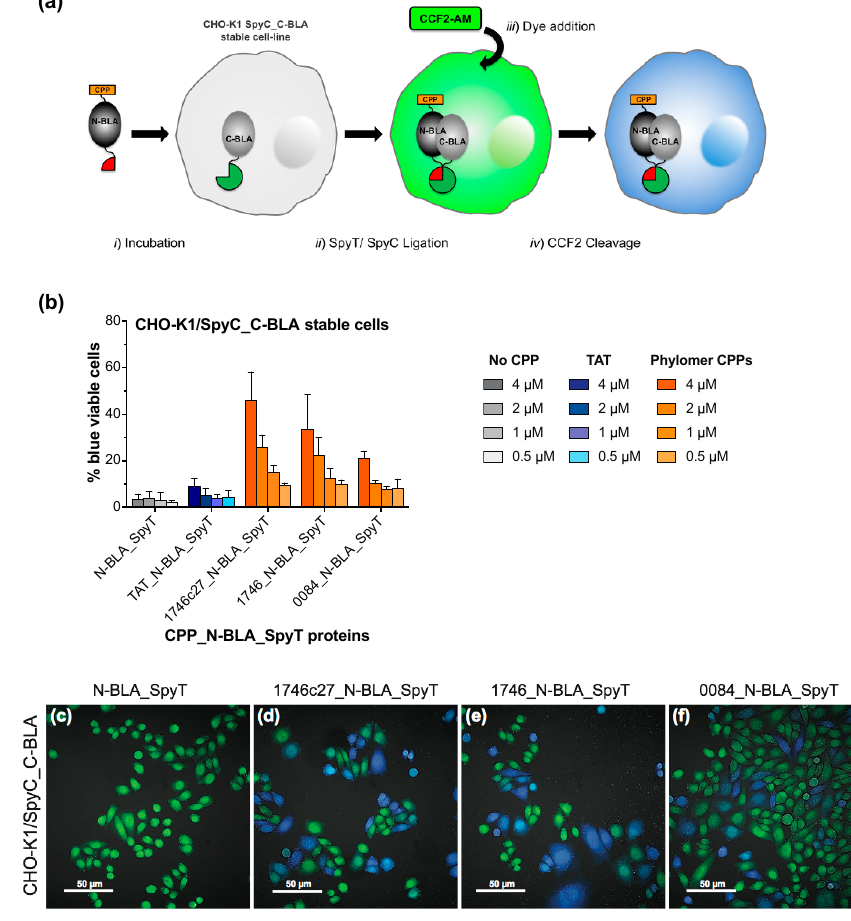
Figure 3. A CPP-mediated split β -lactamase cytosolic delivery assay. ( a ) Live-cell functional uptake can be measured when N-terminal β -lactamase (N-BLA), fused to a CPP sequence, penetrates the cell membrane to complement C-terminal β -lactamase protein (C-BLA) in the cytosol (step i ). Expression of the split β -lactamase moieties as fusions with either SpyTag (CPP_N-BLA_SpyT) or SpyCatcher (SpyC_C-BLA) facilitates rapid formation of functional β -lactamase proteins through SpyT/SpyC ligation inside the cells (step ii ). This internalization is detected after addition of dye substrate (step